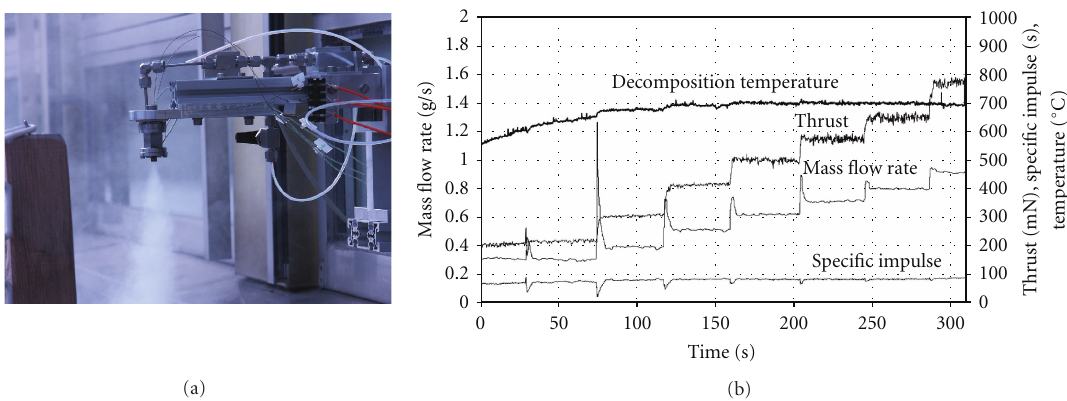
Figure 15: Monopropellant thruster test and direct thrust measurements as a function of the mass flow rate.